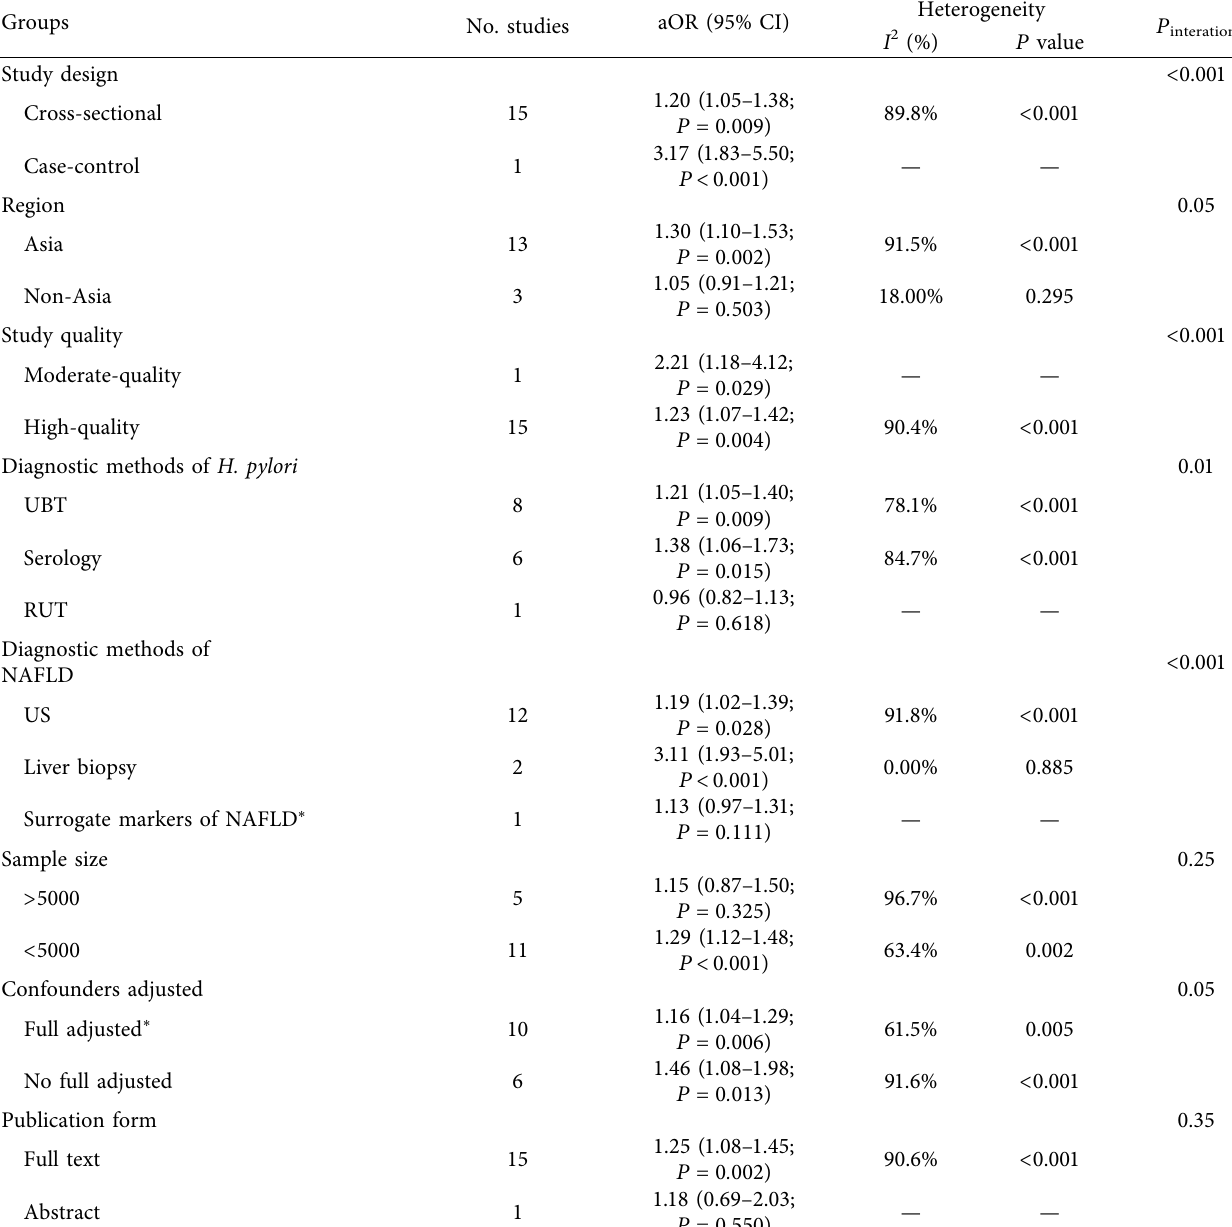
Table 3: Meta-analysis regarding the association of H. pylori infection with NAFLD in studies adjusted for confounders.